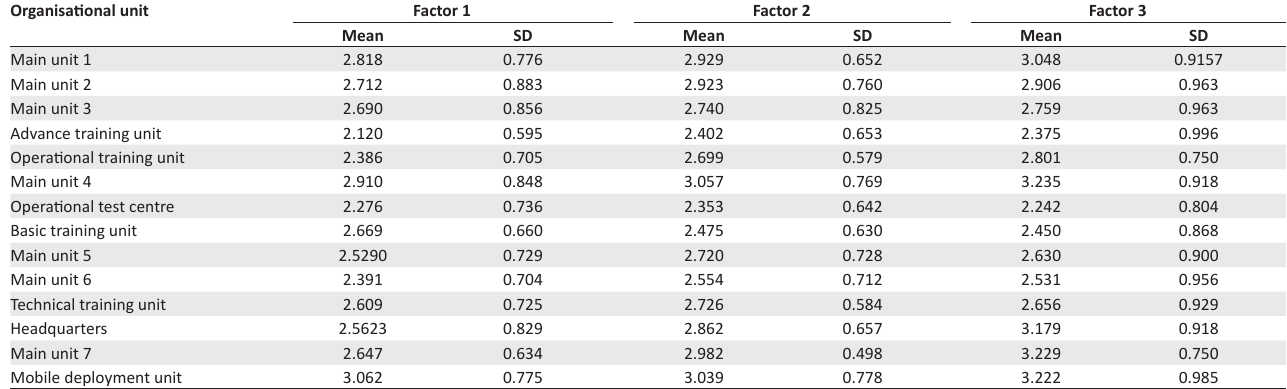
TABLE 10: Descriptive statistics for organisational units.